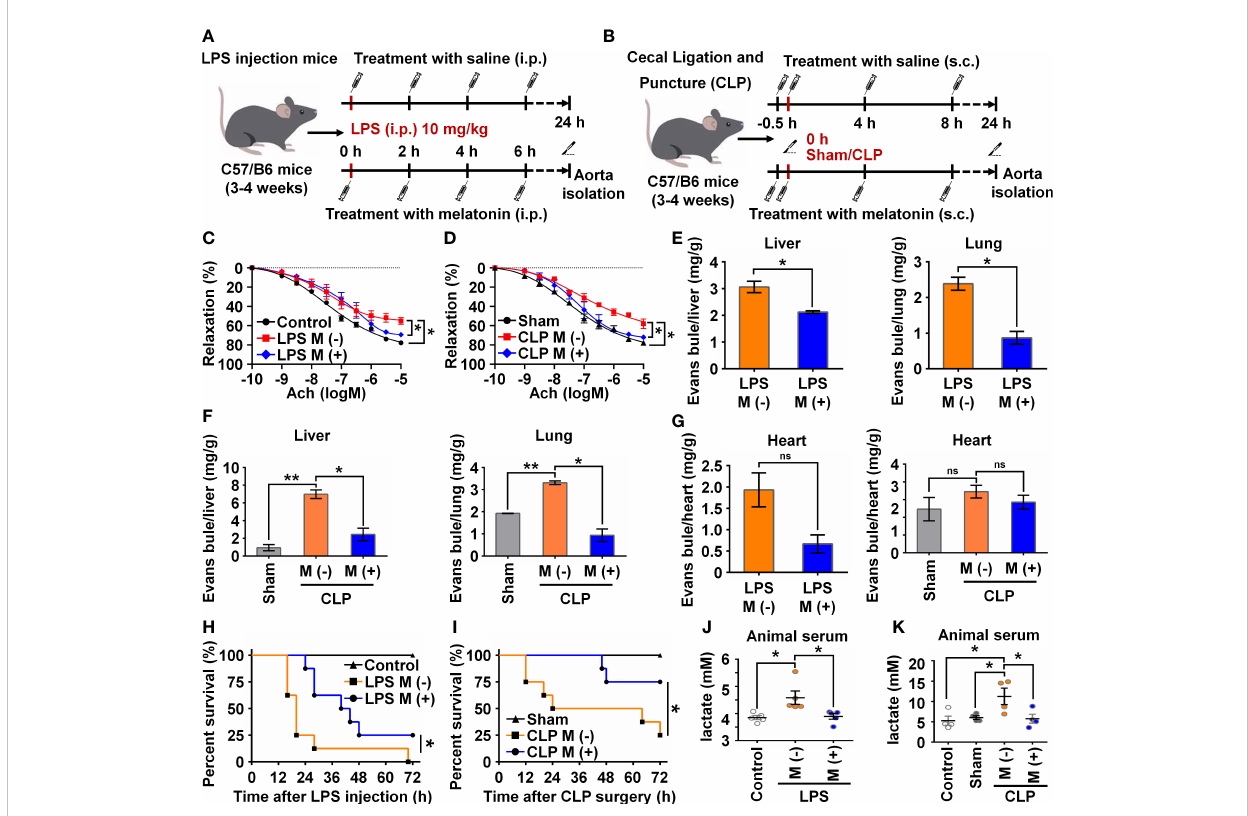
FIGURE 6 Melatonin attenuated sepsis-induced endothelial dysfunction. (A, B) Animal experiment fl ow chart in LPS group (A) and CLP group (B) . (C, D) The endothelium-dependent relaxation function of vessels was measured in LPS group treated without or with melatonin (C) and in CLP group treated without or with melatonin (D) . (E) Evans blue experiment in LPS group treated without or with melatonin was analyzed to test the vascular permeability function of liver (left) and lung (right). (F) Evans blue experiment in CLP group treated without or with melatonin was analyzed to test the vascular permeability function of liver (left) and lung (right). (G) Evans blue experiment in LPS group (left) and CLP group (right) treated without or with melatonin was analyzed to test the vascular permeability function of heart. (H, I) The survival rate of LPS group (H) and CLP group (I) treated with or without melatonin was analyzed (n=8 in each group). (J, K) The serum lactate level in LPS group (J) and CLP group (K) was tested by a lactic acid assay kit. Data are shown as the mean ± SEM. * p < 0.05. ** p < 0.01. ns, no signi fi